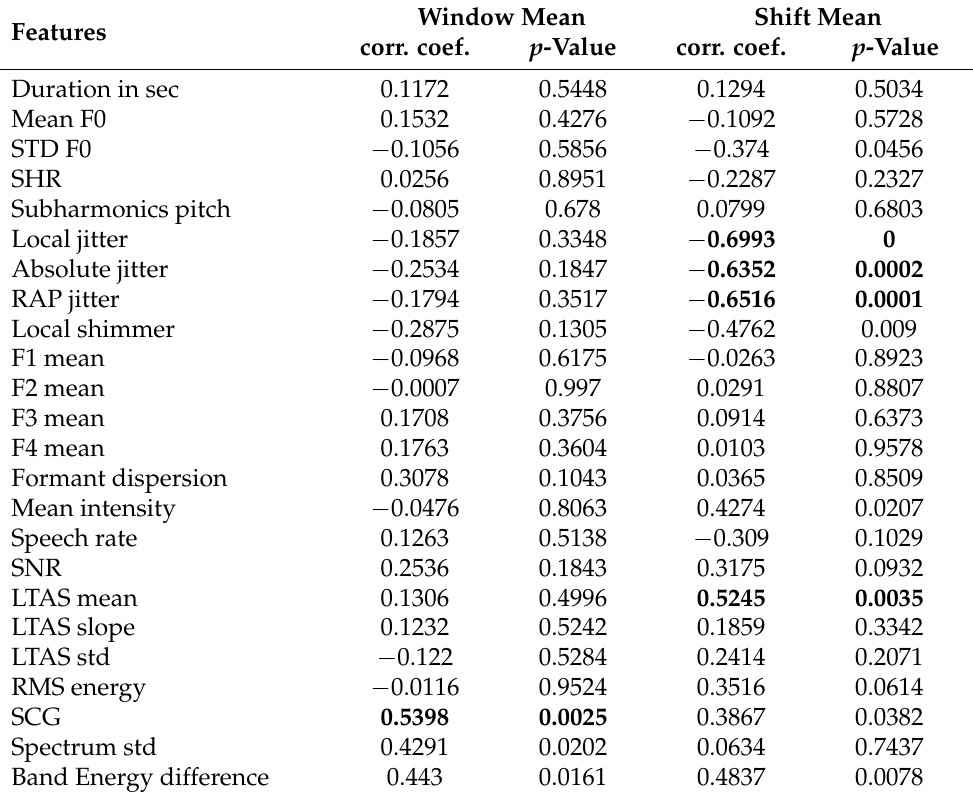
Table 4. Linear correlation coefficients with uncorrected p -values among speaker’s voice features and Window and Shift mean values for IDEA speakers. The statistical significance after Benjamini– Yekuteli correction is shown in